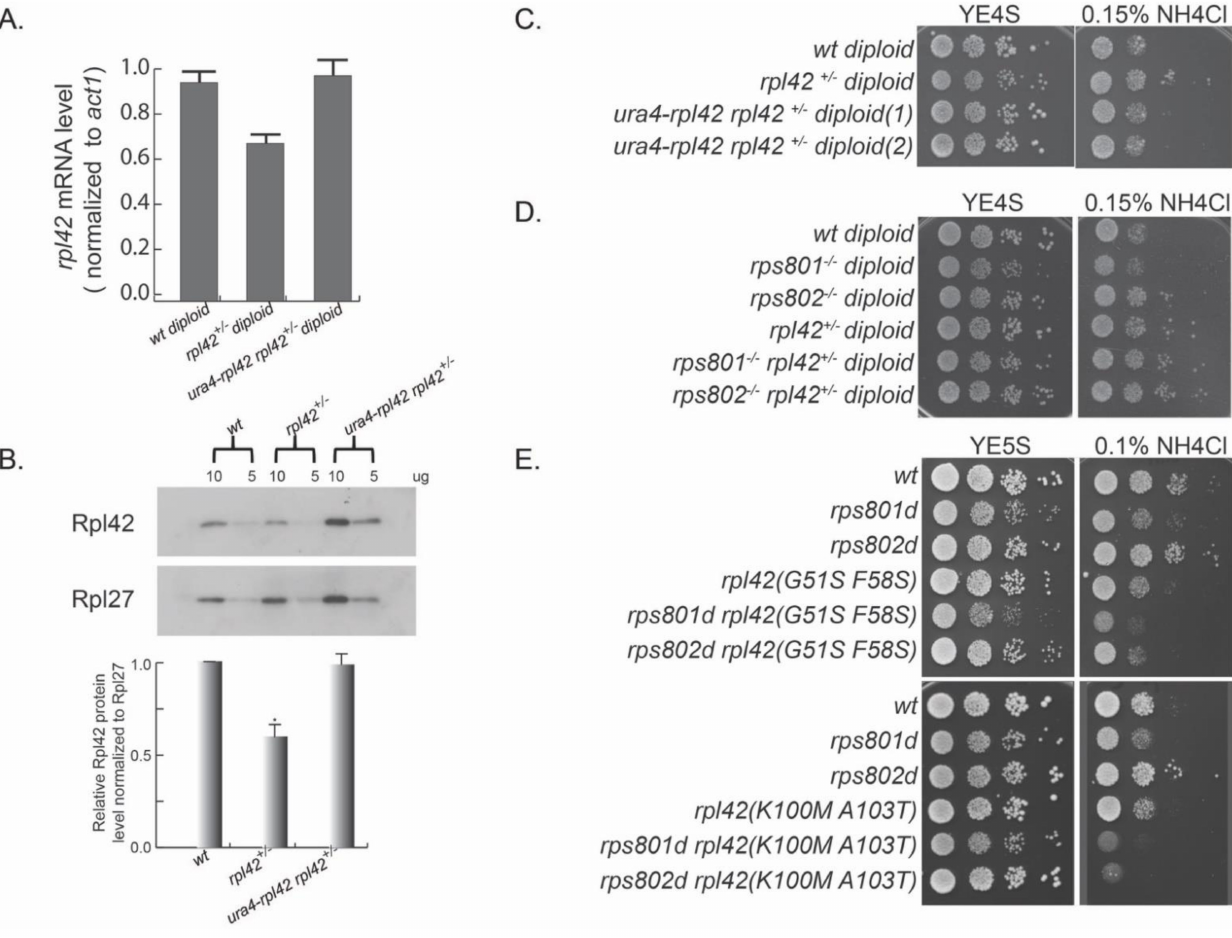
Figure 2. Differential Rpl42/eL42 protein level contributes to the paralog − specific phenotype in Rps8/eS8 paralog deletions. ( A ) Quantification of the relative Rpl42/eL42 mRNA levels in rpl42 +/ − heterozygous diploid cells. ( B ) Quantification of the relative Rpl42/eL42 protein levels by Western blotting in diploid cell extracts. Ten or five micrograms of the total protein samples were loaded. p − values were obtained by the two − tailed Fisher’s exact test. * p < 0.05. ( C ) Reduced